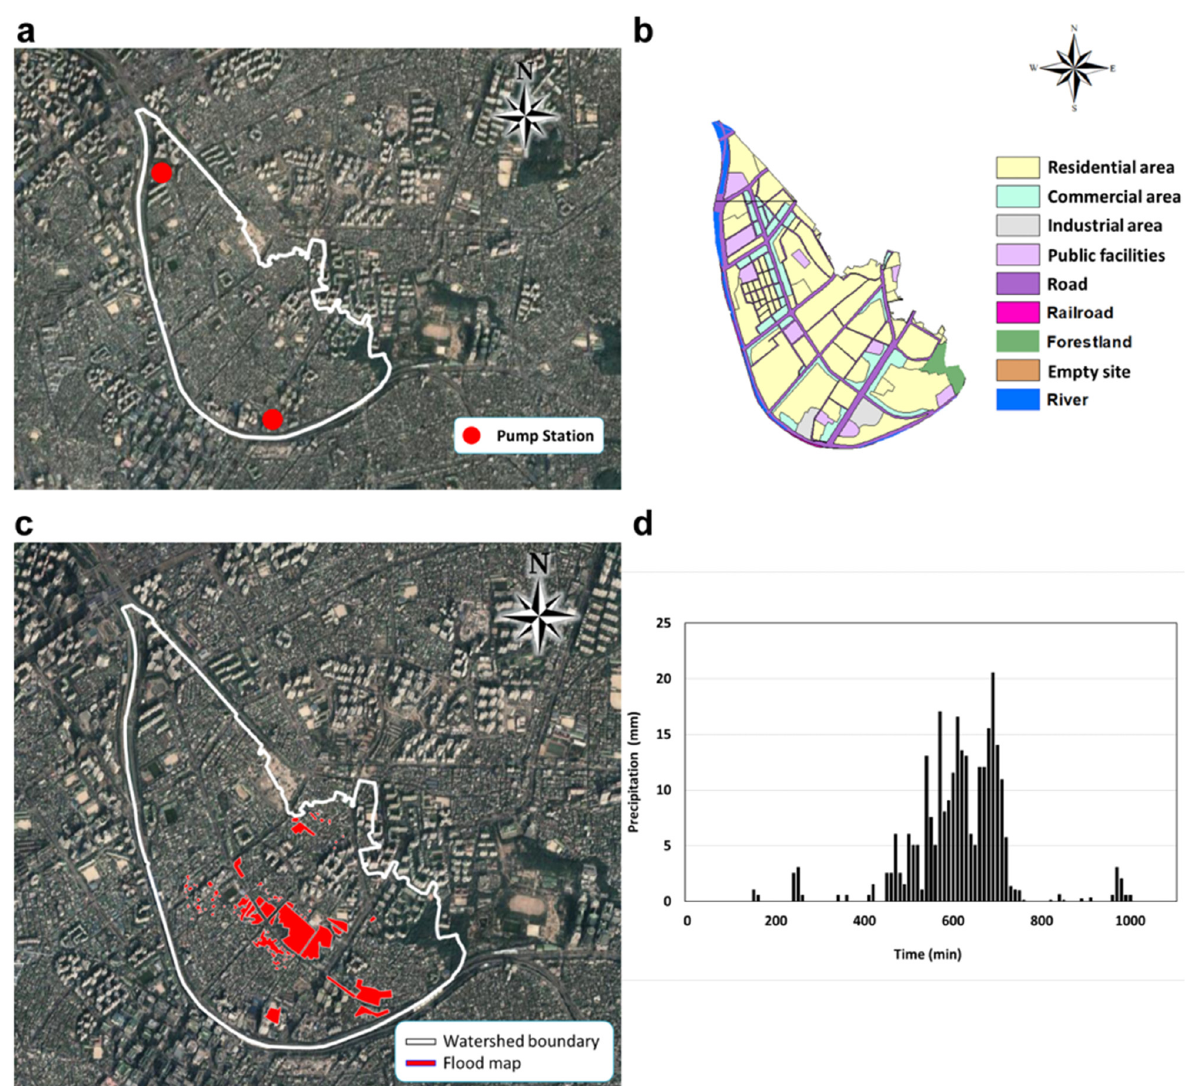
Figure 5. ( a ) Watershed boundary, ( b ) land use status, ( c ) flood damage history, and ( d ) damage- causing rainfall (21 to 22 September 2010) in the Dorim watershed, Seoul.